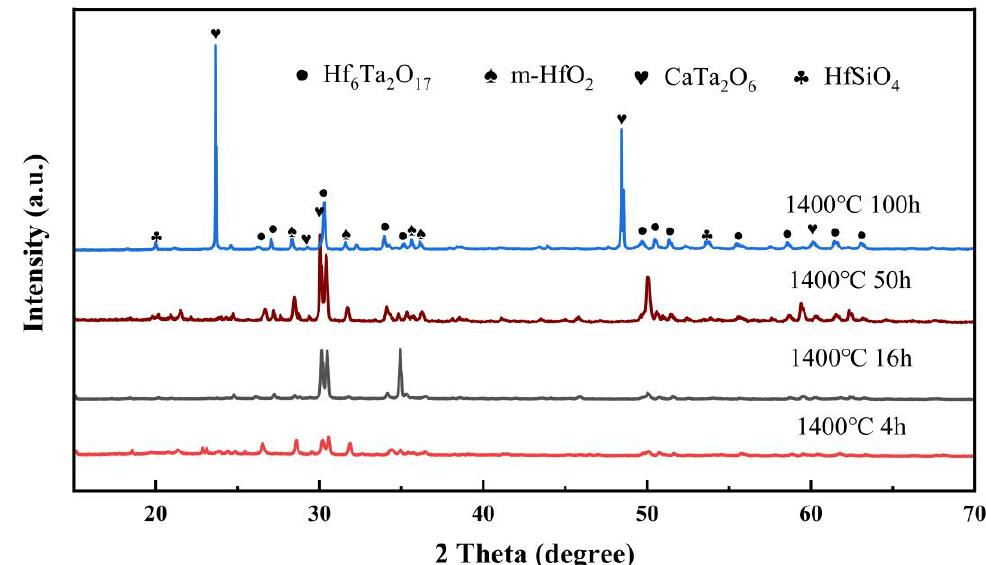
Figure 14. XRD patterns of Hf 6 Ta 2 O 17 ceramic after CMAS corrosion at 1400 °C for 4 h, 16 h, 50 h and 100 h.